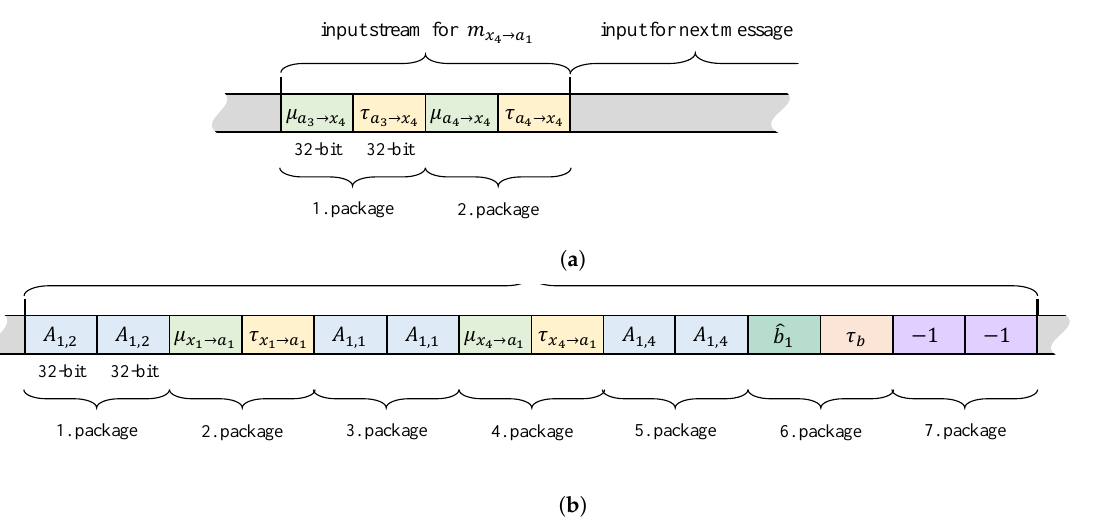
Figure 4. The diagrams illustrate the designed protocol of the AXI input stream to both co-processors through an example. In ( a ), the stream towards processor C x → a is shown, whereas ( b ) depicts the input of processor C a → x . The chosen examples correspond to messages of the factor graph in Figure 1 and LES